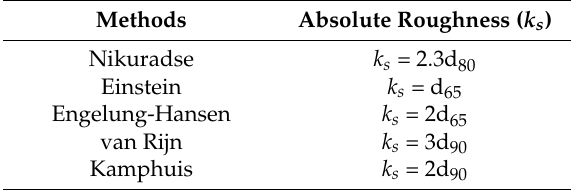
Table 1. The dependence between absolute roughness and characteristics of sediment grain